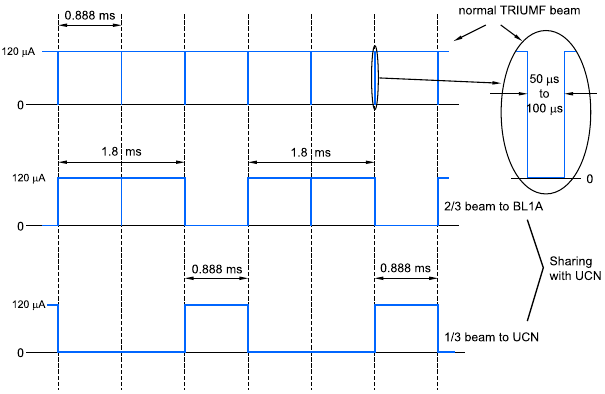
FIG. 1. Sharing of the main beam from the cyclotron (normal TRIUMF beam) between beamline 1A and beamline 1U. Beam is diverted into beamline 1U by switching on the kicker magnet during the 50 – 100 μ s notch duration, then switching it off during the next notch. The pulser period is 0.888